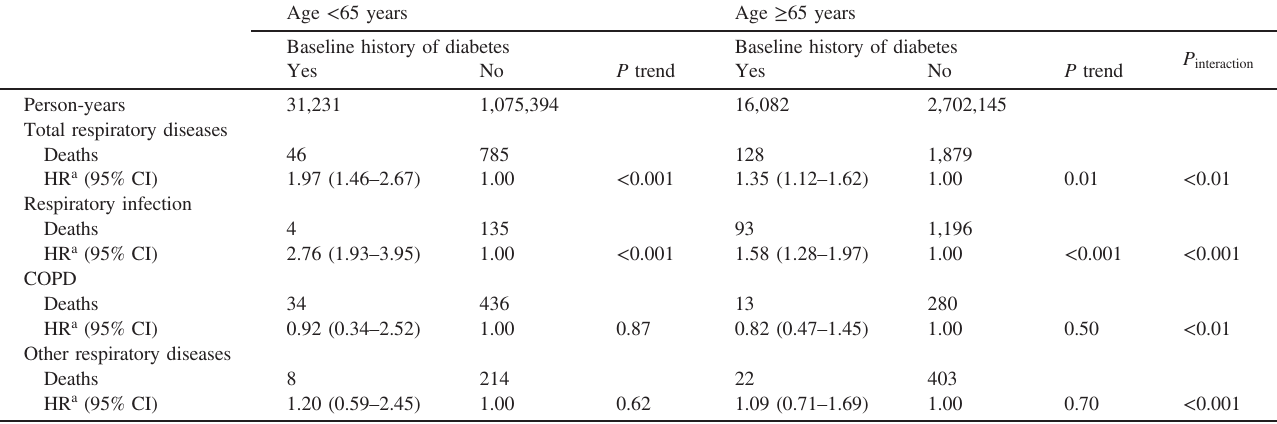
Table 3. Multivariable hazard ratios of mortality from respiratory diseases according to baseline history of diabetes, strati fi ed by age groups